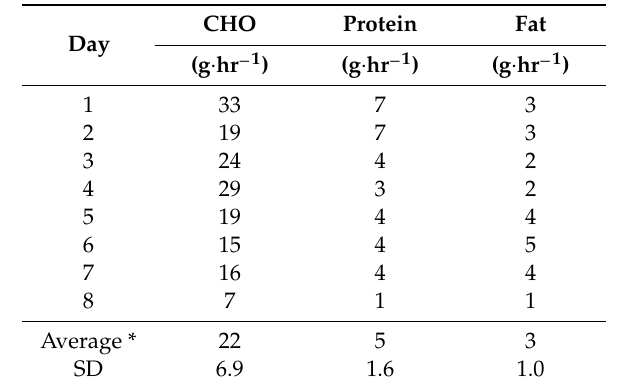
Table 3. Daily macronutrient intake for 20 waking hours derived from CHO, protein, and fat, expressed as intake (g) per hour.